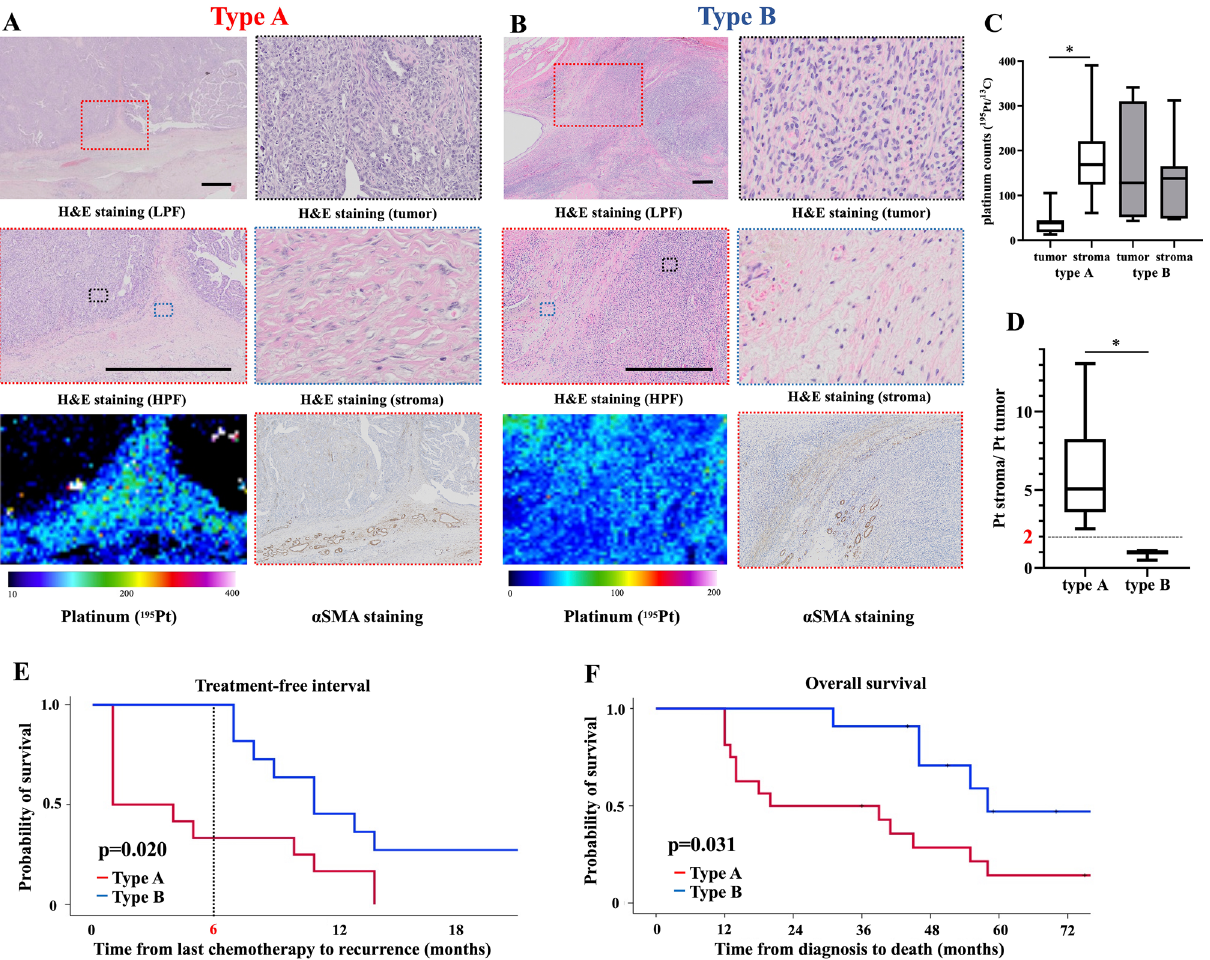
Figure 4. Platinum distribution and survival in the patients with HGSOC. ( A ) Representative images of types A. In type A, there is little platinum accumulation in the tumor but accumulation in stroma. Scale bar: 200 μm. ( B ) Representative images of type B. In type B, platinum was also present in the tumor. Scale bar: 200 μm. ( C ) 195 Pt counts in tumor and stroma in types A and B. The 195 Pt counts in the type A tumors were significantly lower than those in the stroma. ( D ) The platinum counts in the stroma in the type A cases were over twofold those of the the tumors. ( E ) Kaplan–Meier analysis of the treatment-free interval (TFI) in both groups in of patients treated with platinum-based agents in adjuvant chemotherapy. The type A patients developed significantly earlier recurrence, and most of them were diagnosed with platinum-resistant recurrence (p = 0.020). ( F ) Kaplan–Meier analysis of the two groups’ overall survival (OS). The type A patients had significantly shorter survival compared to the type B patients ( p = Of the 27 cases, 16 (59.2%) were classified into type A and the other 11 (40.7%) were type B. The patient’s characteristics by group are presented in Table 3. No significant differences between the two types were observed in age, NAC courses, duration from NAC to IDS, CA125 level at diagnosis, or the rate of complete surgery. Tumor regression after chemotherapy was significantly higher in the patients with type B (type A: 50% vs type B: 70%, p = 0.029). In terms of recurrence, none of the type B patients in type B experienced recurrence within 6 months from the last platinum-based drug. Conversely, nine of the 16 (56.3%) type A patients experienced recurrence within 6 months (Treatment-Free Interval [TFI] < 6 months). TFI was defined that interval from last chemotherapy to recurrence or death. Among the 16 type A patients, though 11 were treated with platinum- based agents in adjuvant chemotherapy, 4 were treated with non-platinum-based chemotherapy based on a clinical diagnosis of platinum resistance from pathological findings. The other one rejected additional adjuvant chemotherapy. Eight of the nine (88.9%) type A patients treated with the same platinum-based chemotherapy after IDS relapsed within 6 months. Three of the four type A patients treated with non-platinum-based agents after IDS had a TFI > 6 months. Although the Kaplan–Meier analysis did not reveal a significant difference in TFI between the type A and B patients (Suppl. Fig. S4A, p = 0.160), it identified a significantly difference between the type A and B in only patients who were treated post-surgery with platinum-based agents (Fig. 4E, p = 0.020). With respect to OS, all but one of the 11 type B patients lived for > 3 years after diagnosis, whereas eight of the 16 type A patients died within 3 years after diagnosis, demonstrating that the type A patients had a significantly